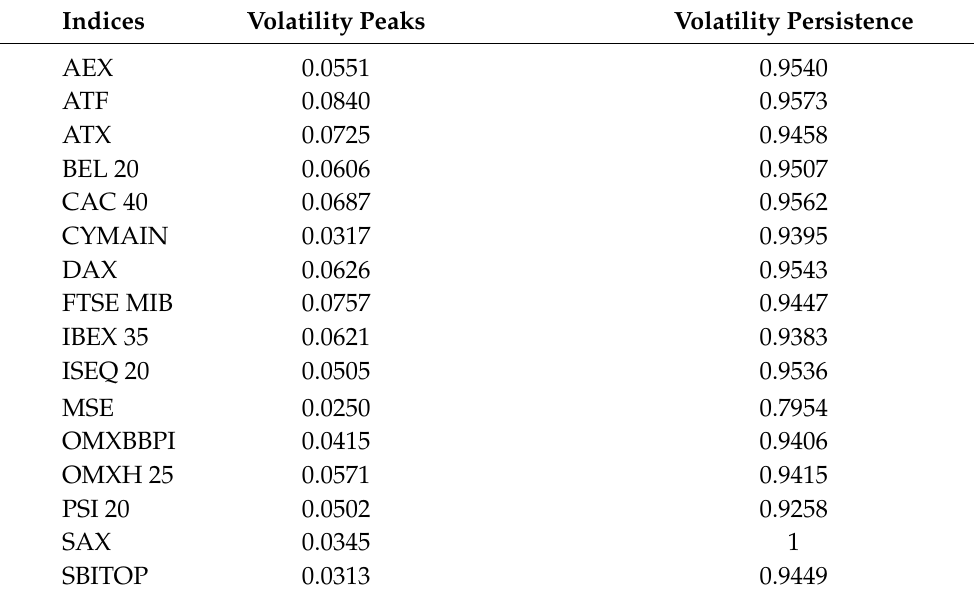
Table 2. Estimated volatility peaks and volatility